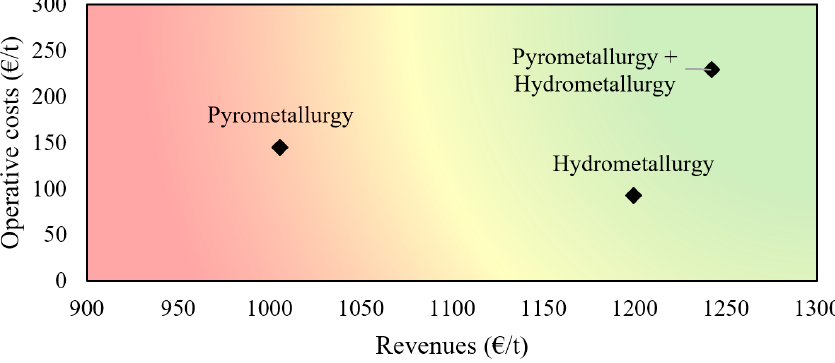
Figure 6. Comparison between operative costs and potential revenues of different LIBs’ recycling strategies